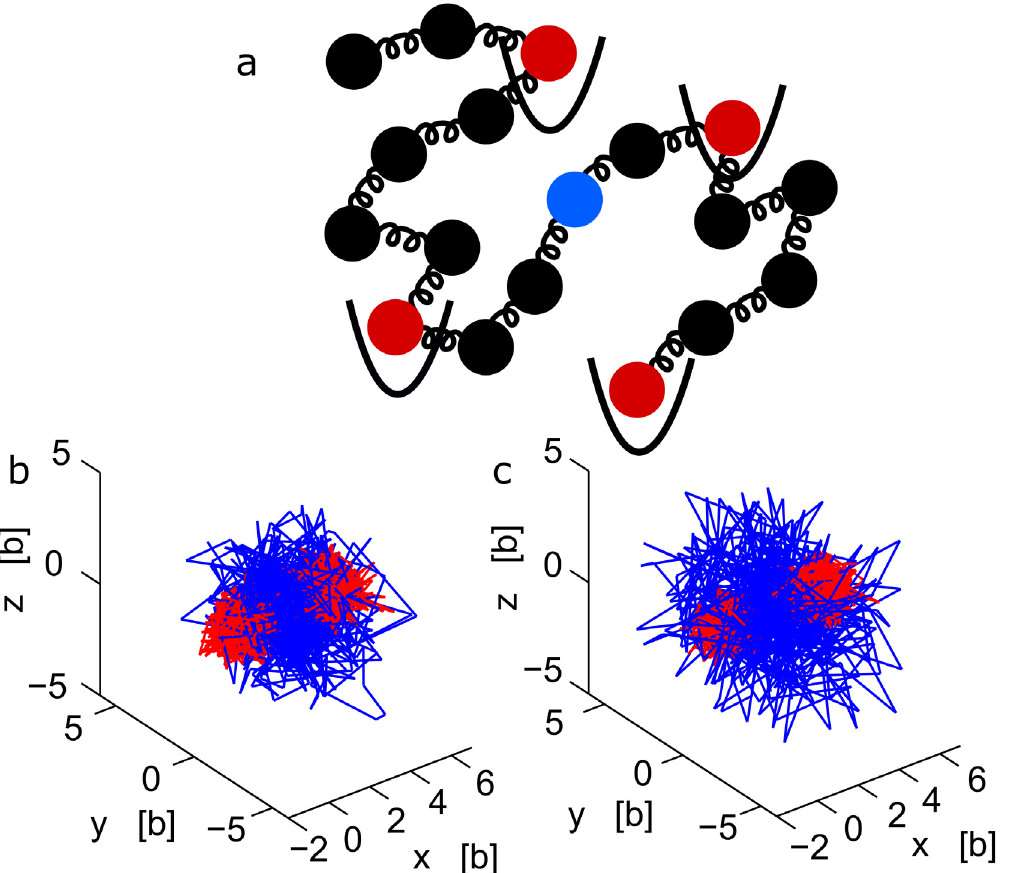
Fig 2. Dynamics of interacting versus observed locus. ( a ) Schematic representation of the nucleus, where one locus is observed and followed with a florescent label while another (non-visible) chromatin locus is interacting with another nuclear element. ( b-c ) Stochastic trajectories of monomers, part of a polymer ( N = 30) where one extremity interacts with a harmonic potential well of strength κ = 2 K B T / b 2 . When the observed monomer is the interacting monomer (red), the trajectory is well localized (b). When the middle monomer of the polymer is tracked, the trajectory (blue) is more extended (c).